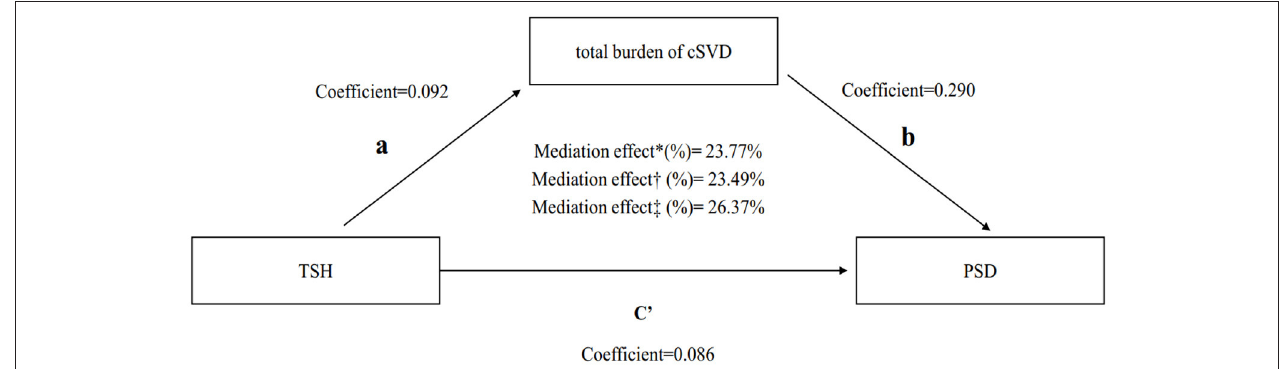
FIGURE 2 | Mediation analysis of total cSVD burden on the association between TSH and PSD. *Unadjusted. † Adjusted by module 1. ‡ Adjusted by module 2. TSH, thyroid stimulating hormone; PSD, post-stroke depression; cSVD, cerebral small vessel disease.